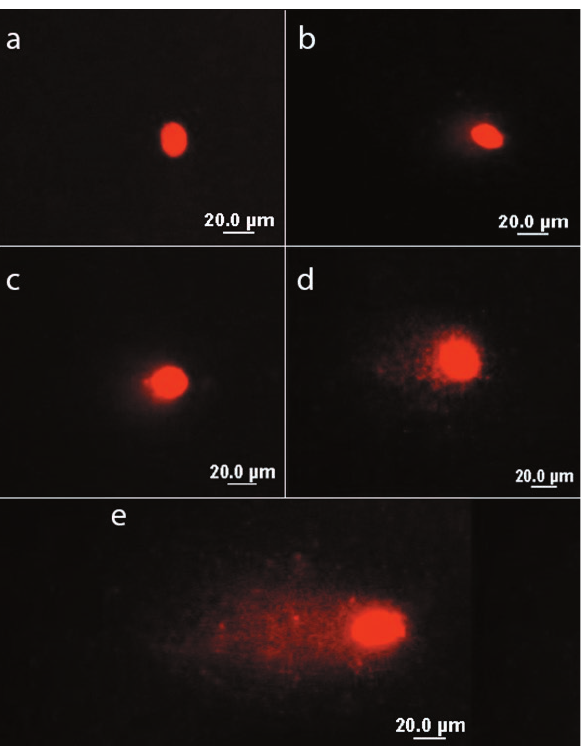
Figure 3. Classifi cation of nuclei according to the degree of dam- age in V.faba with Comet test a) Type 0: undamaged, b) Type 1: tail <0,5 c) Type 2: tail>0,5 or equal to the head, d) Type 3: tail is longer than the head diameter, e) Type 4: tail is approxiametly three times longer than the head.